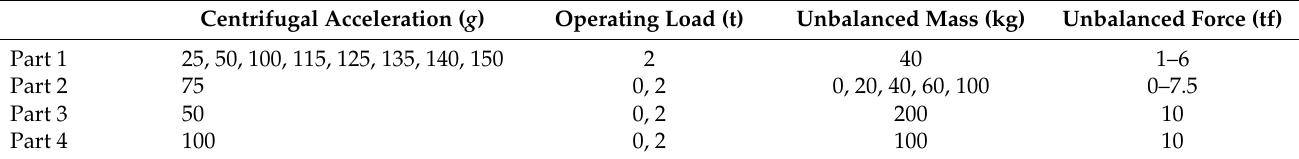
Table 2. Experimental conditions and unbalanced force range for the test